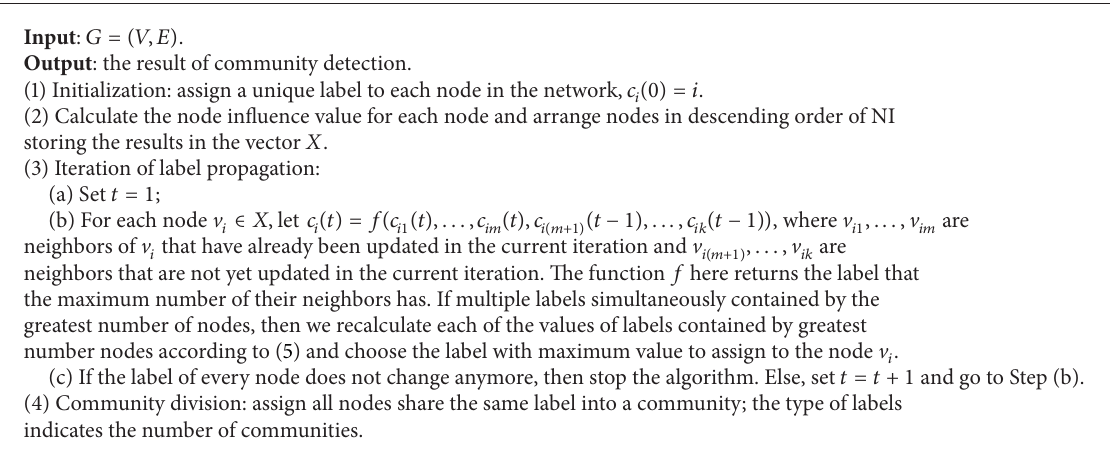
The time complexity of ranking the nodes in descend- ing order of NI: 𝑂(𝑛 log (𝑛))